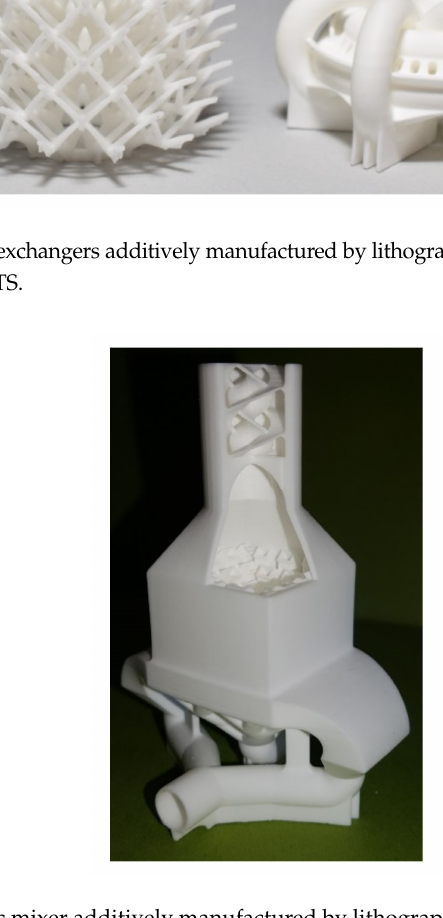
Figure 6. Alumina static mixer additively manufactured by lithography-based ceramic manufacturing (LCM) at Fraunhofer